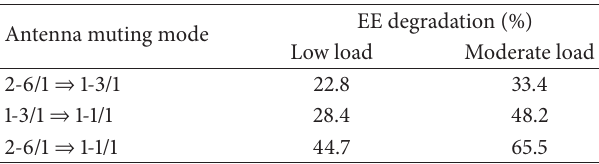
Table 2: EE degradation and power-saving in different antenna switching-off